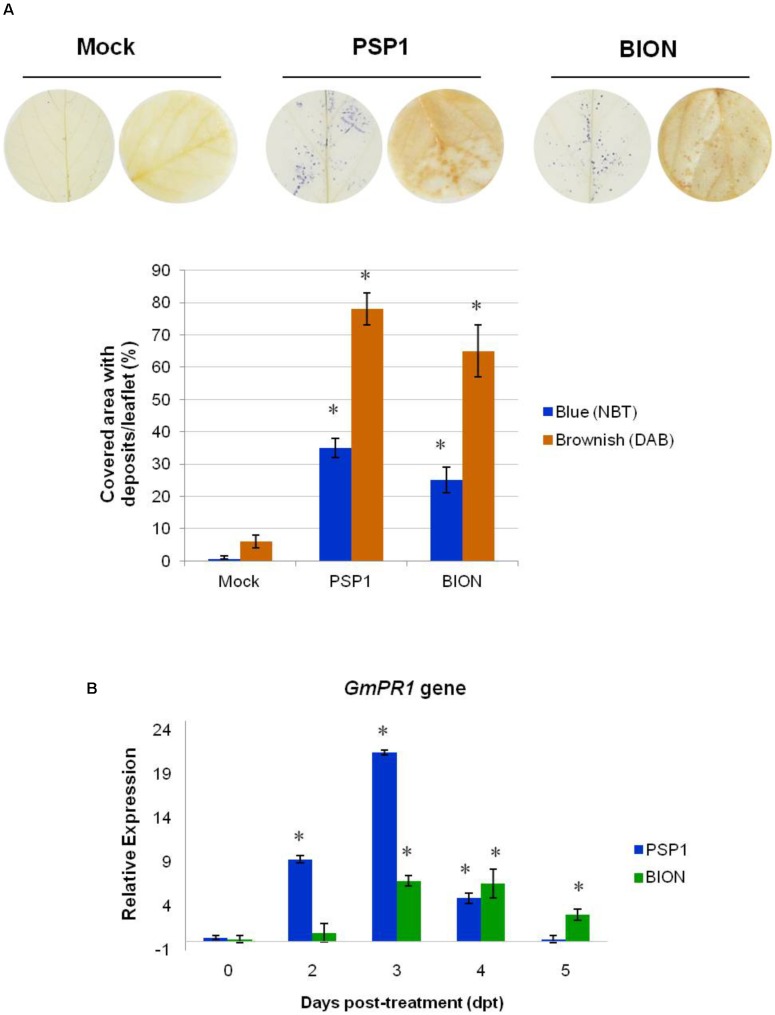
Induction of defense responses by PSP1 and BION treatments in soybean plants. (A) Accumulation of superoxide (O2•−) and hydrogen peroxide (H2O2) was analyzed in foliar tissue of plants treated with mock, PSP1 (0.5 U/ml) and BION (0.5 mg/ml) 4 h post-treatment by NBT and DAB staining methods, respectively. Twenty biological replicates (leaflets) were assessed for each treatment and the experiment was carried out twice. Factorial ANOVA test indicated no significant differences between the two experimental repetitions (p > 0.05) and results from one representative experiment are shown. Quantification of ROS accumulation was performed by measurement of the foliar area with blue (O2•−) and brownish (H2O2) deposits with ImageJ software, and expressed as covered area/leaflet. Mean and standard error (SE) values of covered area/leaflet are reported for each treatment calculated from one representative experiment with 20 biological replicates. Asterisks indicate significant differences with respect to mock-sprayed control plants according to Dunnett’s test (p < 0.05). Each photo shows two representative leaf disks from 20 leaflets analyzed for each treatment 4 h after application. (B) Time course of quantitative expression of gene GmPR1 in response to treatment of soybean plants with PSP1 and BION. Leaf samples of plants treated with mock, BION and PSP1 were collected at 0, 2, 3, 4, and 5 dpt. Two biological replicates (obtained from a poll of leaflets from three plants) were tested thrice (technical replicates) for each treatment and the experiment was carried out twice. Relative expression levels were calculated using the expression of the soybean beta-tubulin (GmTUBB2) gene as non-variable constitutive expression for normalization of values. Expression data were calibrated against mock-treated plants sampled at each time point. Data from the two experiments were considered in the analysis. For each time point, mean levels of relative expression and SE are reported for each treatment calculated from a pool of two experiments with two biological replicates assessed thrice (technical replicates). Asterisks indicate significant differences with respect to mock-sprayed control plants, calculated by fgStatistics software (P < 0.05).